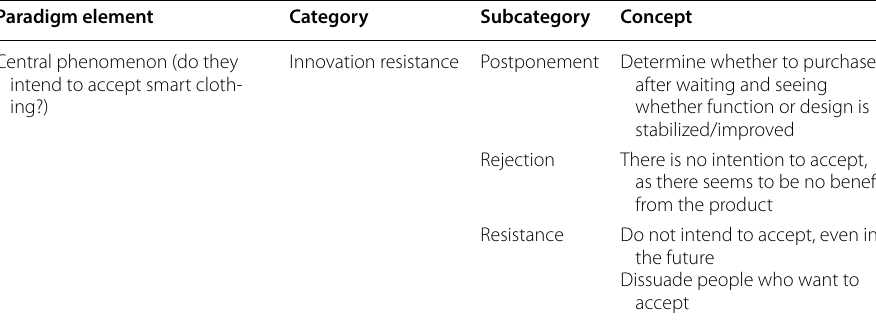
Table 2 Categories, subcategories, and concepts of central phenomenon Paradigm element Category Subcategory Concept Central phenomenon (do they intend to accept smart cloth‑